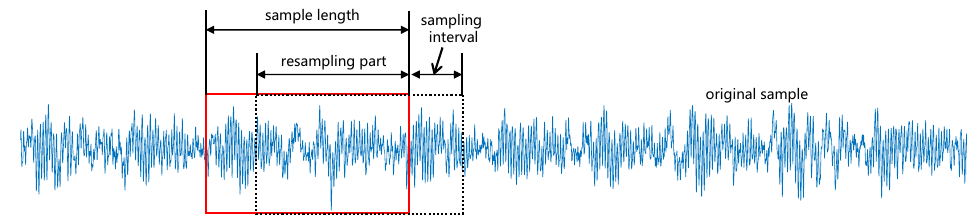
Figure 5. Illustration of the resampling